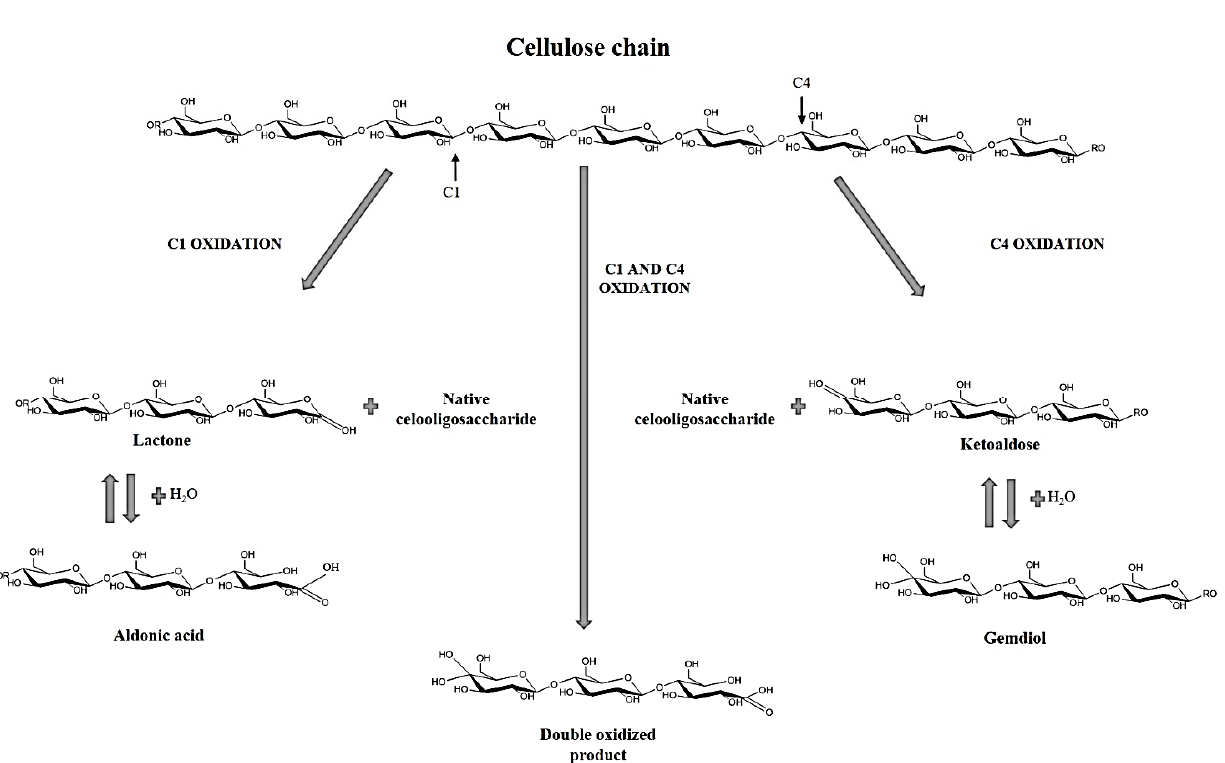
Figure 1. Reaction scheme of LPMO cellulose degradation, showing the products depending of the regioselectivity of the enzymes.